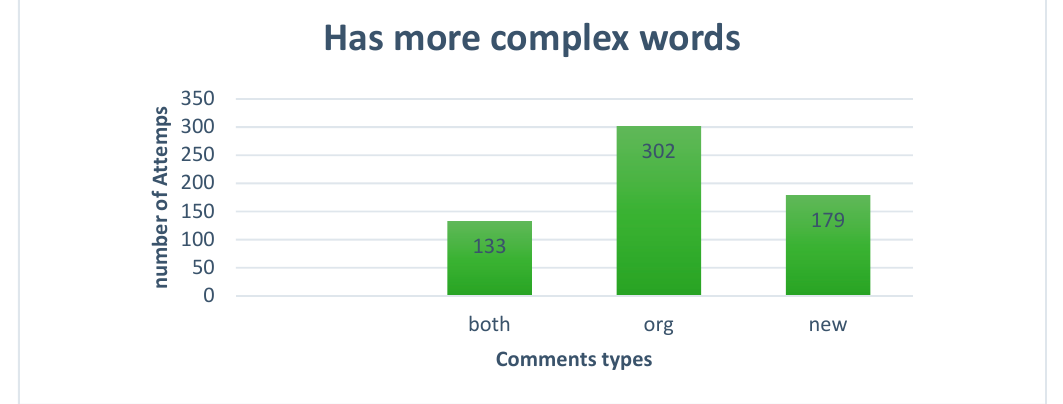
Figure 16. The result of the question: which of the two comments has more complex words ? Where “org” is the original comment from the sample.